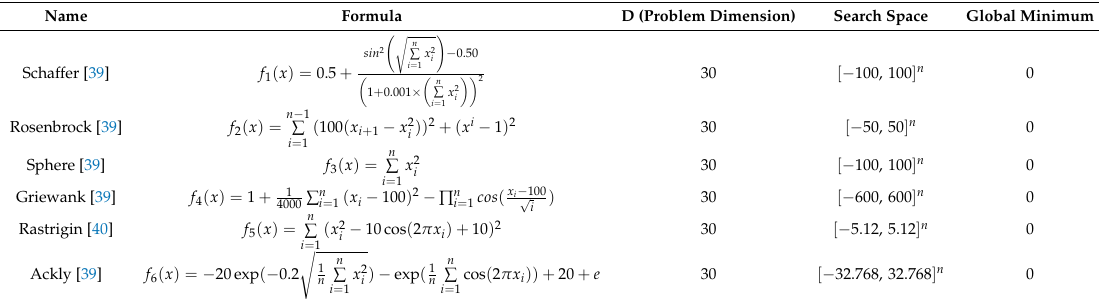
Table 1. Studied benchmark functions.